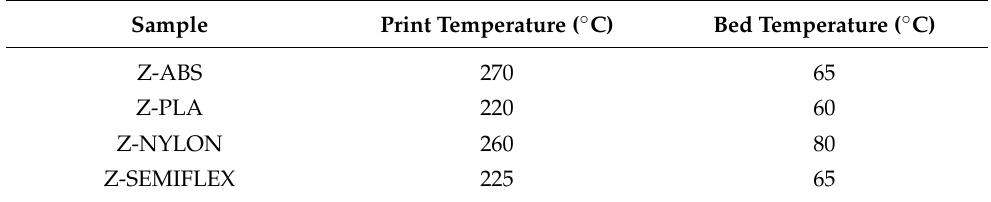
Table 1. Print and bed temperature